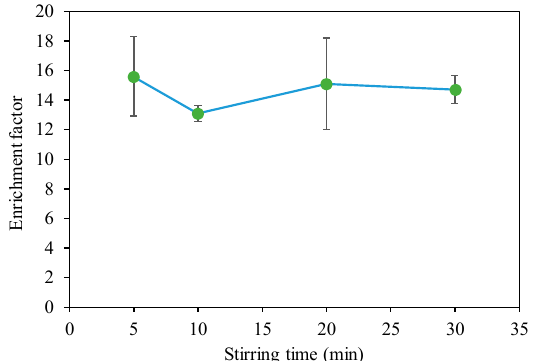
Figure 2. Effect of the magnetic stirring time (sorption time) on the enrichment factor for Pb with magnetite Fe 3 O 4 . Sample: Pb 1 ng·mL − 1 , 100 mL; pH: 5; magnetic stirring desorption: 0.1 mol·L − 1 HNO 3 1 mL.